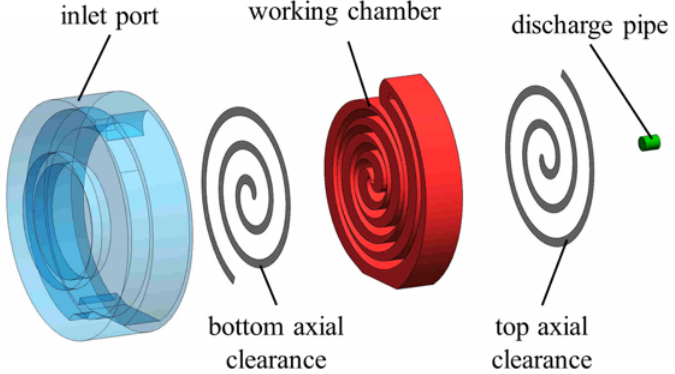
Figure 3. Fluid domain in the scroll compressor.